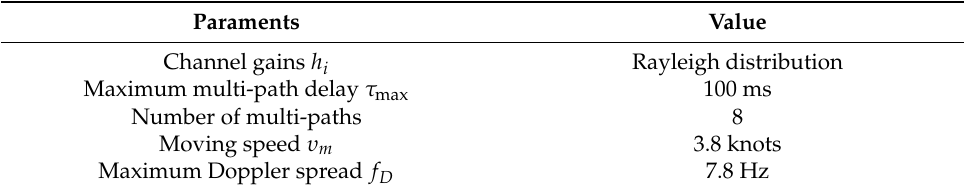
Table 3. Parameters of statistic simulation channel.